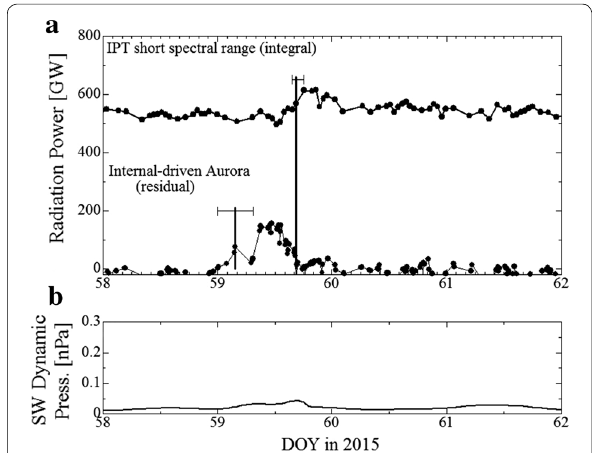
Fig. 5 a Aurora and IPT brightenings on day-of-year (DOY) 59. The periodic System-III variation (period: 10 h) has been removed from the original aurora light curve. The vertical lines indicate the start times of the brightenings. The error bars for the time are also pre- sented. b Prediction of the dynamic SW pressure